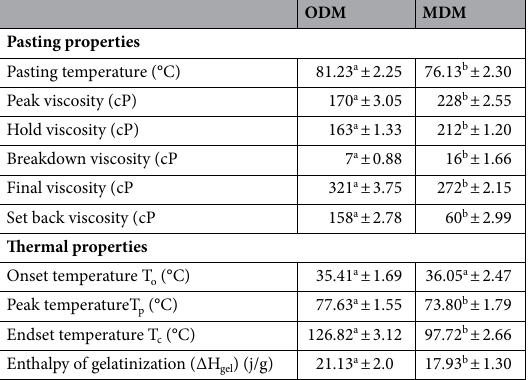
Table 4. Pasting and thermal properties of optimized dry mix (ODM)and market dry mix (MDM). Mean values in rows with different superscripts are significantly different at p ≤